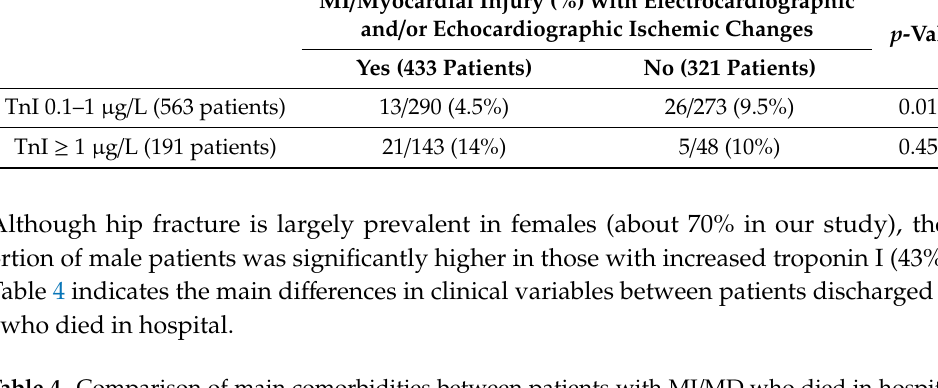
Table 4. Comparison of main comorbidities between patients with MI / MD who died in hospital or were discharged